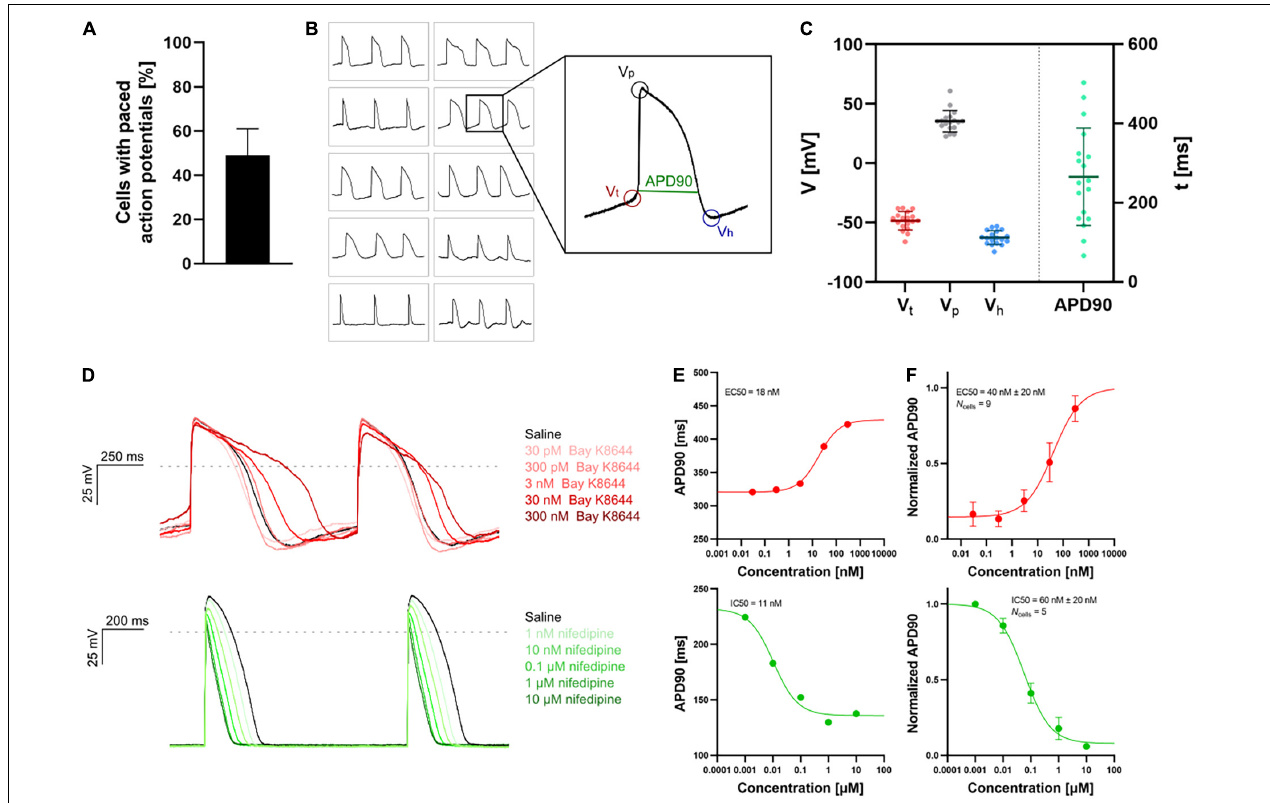
FIGURE 7 | APC current-clamp measurements of paced action potentials and APD90 concentration-response plots. (A) The percentage of successful experiments displaying paced action potentials [ V p > 0 mV, resting membrane potential (RMP) < –40 mV]. Data is avg ± SD of three measurement plates (each of 48 recording sites). Assay success rate was 10%–30% out of 48 sites. (B) Paced action potentials from 10 individual hiPSC-CMs within a single measurement plate (left) and an expanded action potential displaying the extracted parameters: threshold potential ( V t ), peak potential ( V p ), hyperpolarization potential ( V h ), and action potential duration at 90% repolarization (APD90). (C) Plot of extracted parameters, V t (red), V p (gray), V h (blue), and APD90 (green, ms) for 18 individual hiPSC-CMs with the avg ± SD (solid lines). (D) Paced action potentials for saline controls (black traces) and in response to increasing concentrations of Bay K8644 (top, traces in